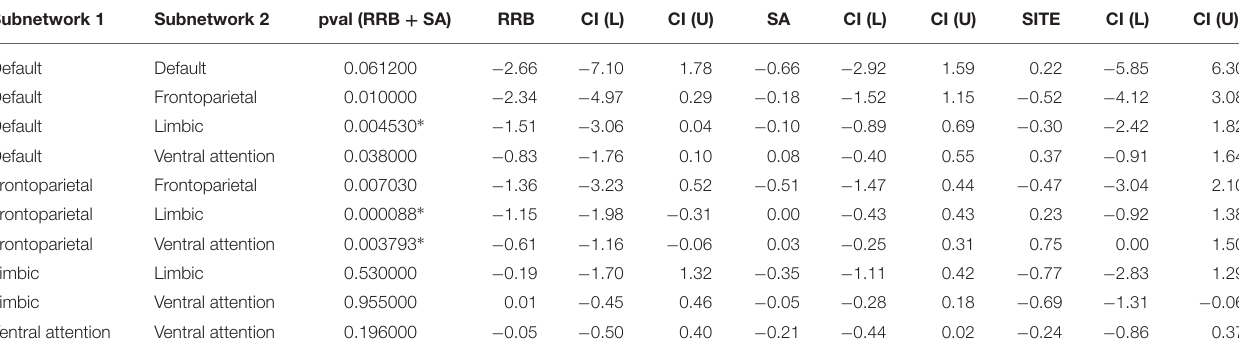
TABLE 1 | Joint ADOS covariate effects on subnetwork density.